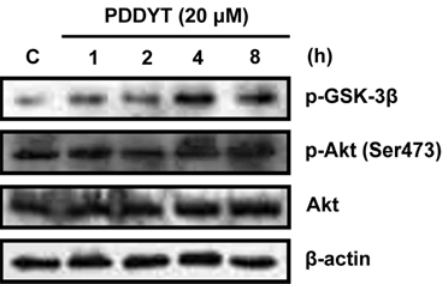
Figure 3. The p-GSK-3 β , p-Akt (Ser 473) and Akt expressions after Hepa 1c1c7 cells were treated with 20 μ M PDDYT for indicated incubation